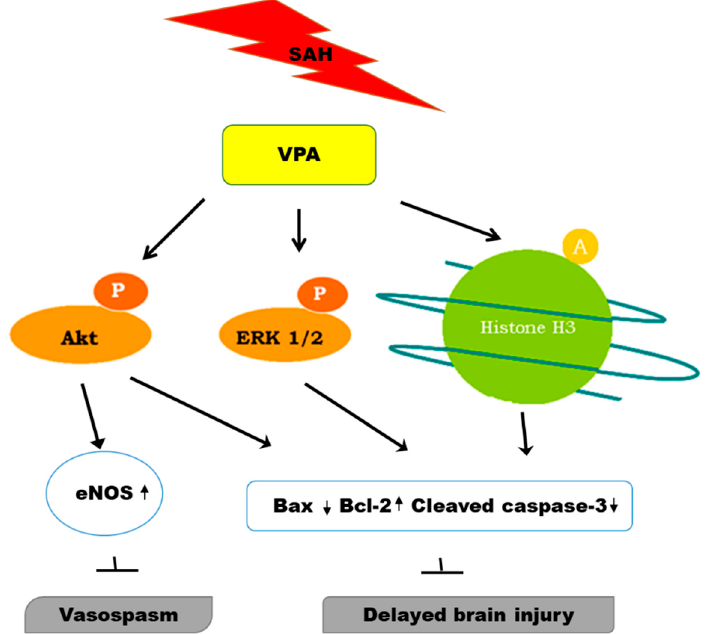
Figure 6. Hypothesized regulatory anti-vasospastic and neuroprotective role of VPA in SAH group.